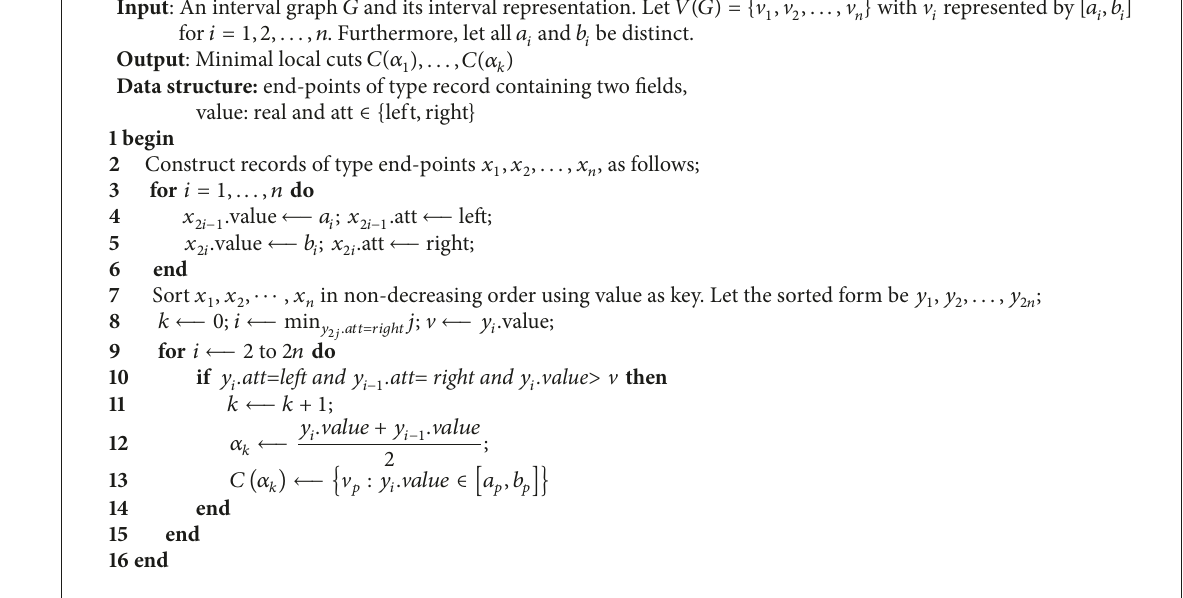
Algorithm 1: Algorithm minimal local